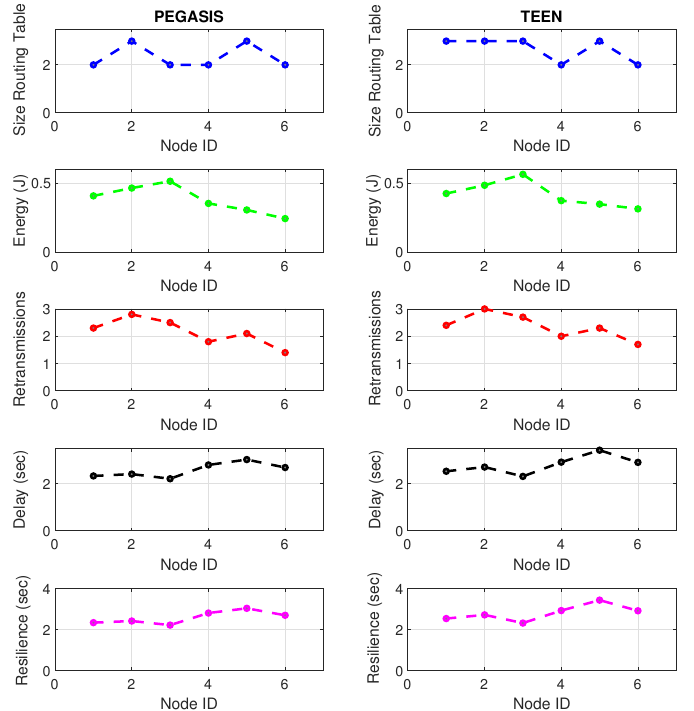
Figure 19. Zigbee network deployment under normal